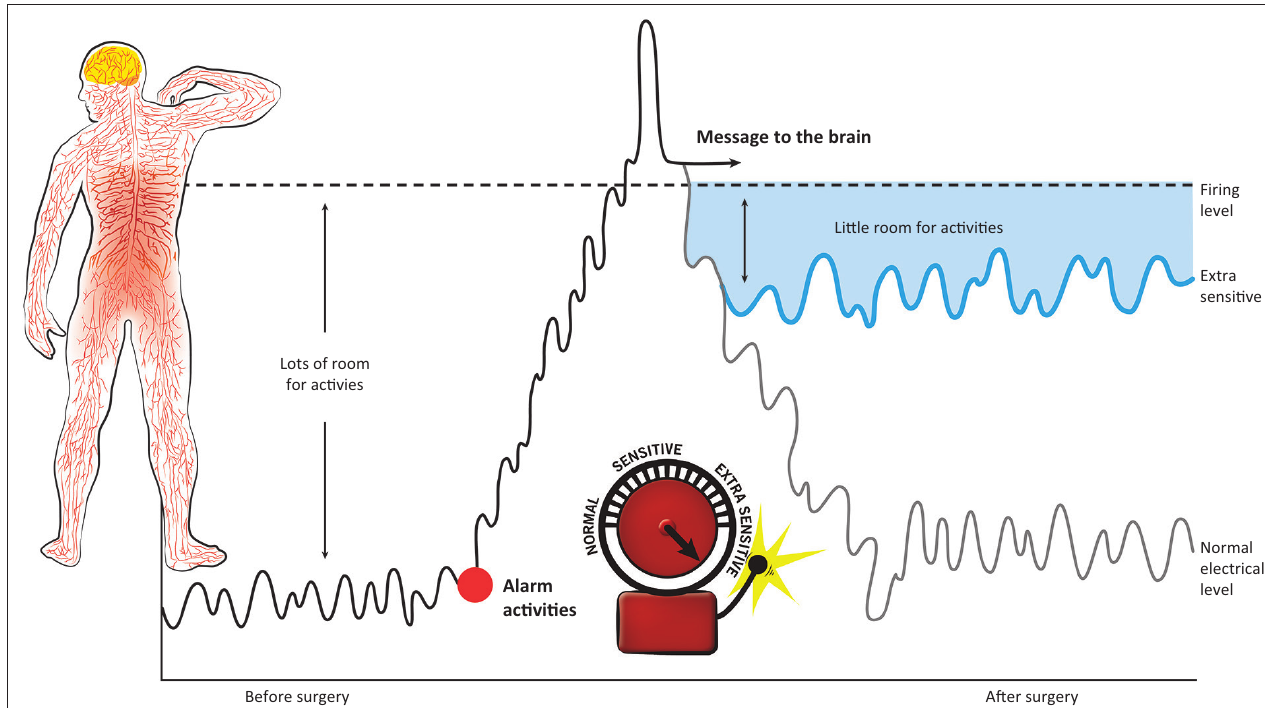
FIGURE 1: Example of picture to explain ‘extra-sensitive alarm’.